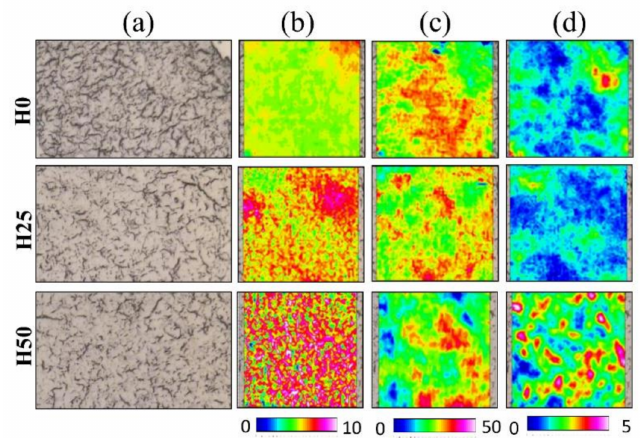
Figure 6. Microphotographs ( a ) of representative liver sections of H0, H25, and H50 groups analysed by FTIRI and topographical distribution of Lipids ( b ), Proteins ( c ), and Glycogen ( d ). Colours from warm (red) to white indicate higher absorbance values, whilst blue colour indicates the lower ones. See colour scale at the